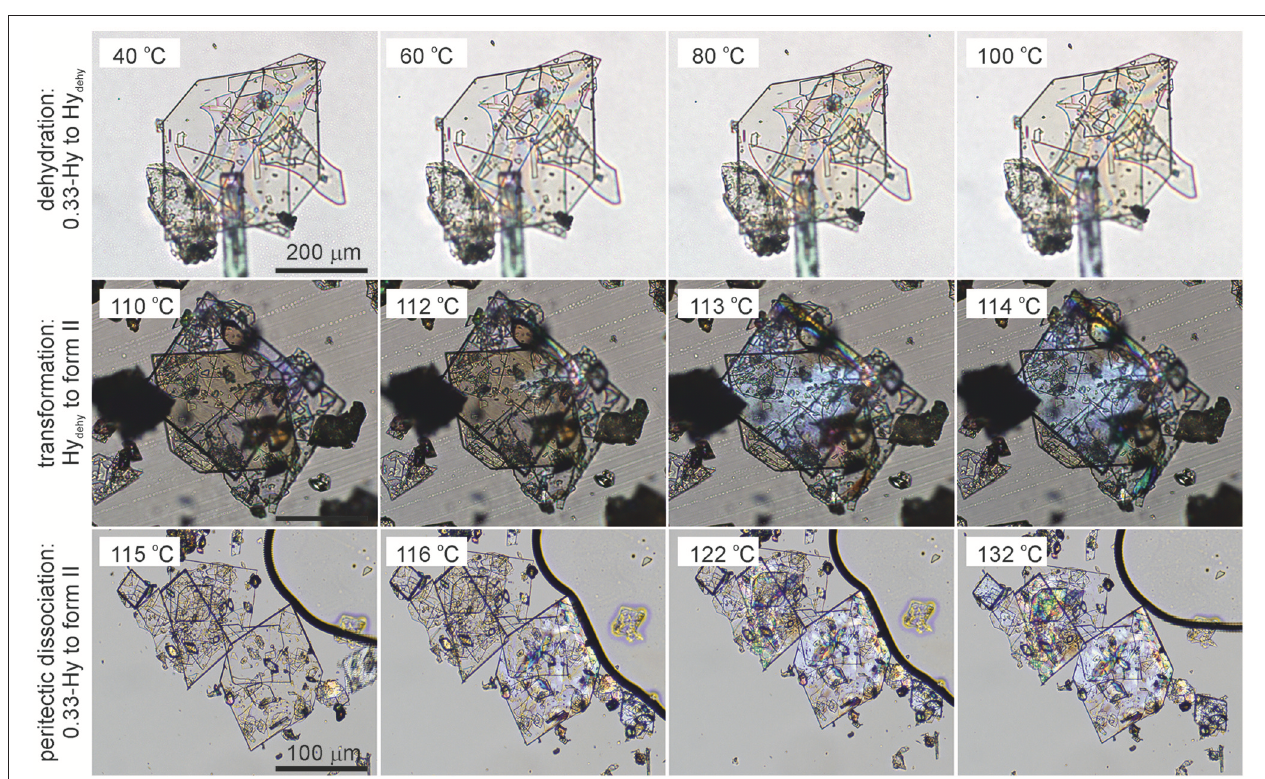
Frontiers in Chemistry |